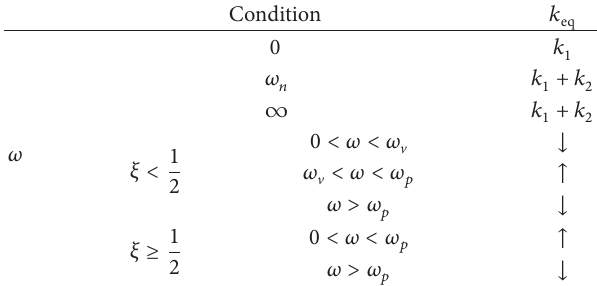
changes with 𝜔 . eq